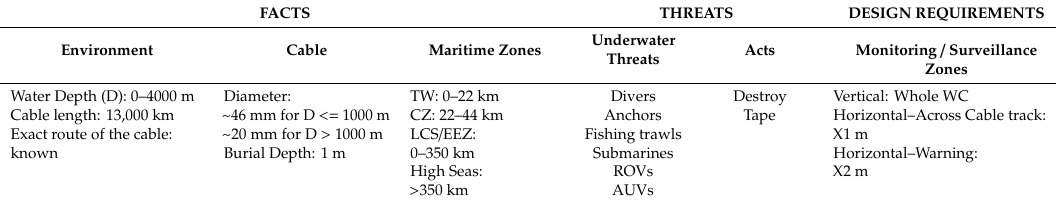
Table 23. Multi-threat sabotage scenario characteristics.